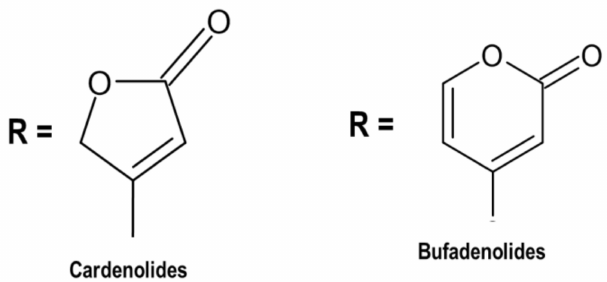
Figure 1. Two classes of cardiac glycosides occurring in nature